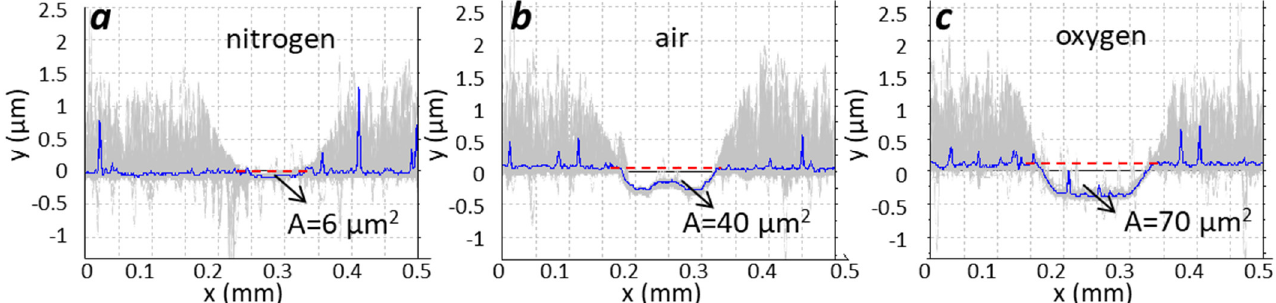
Figure 10. Series of 250 line profiles stacked together from the recorded profiles. The wear track of BAI TiN coating is shown for different surrounding atmospheres (( a )—nitrogen, ( b )—air, ( c )—oxygen). The scanning area was 0.5 mm × 0.5 mm. The blue profile represents the level of coating, while grey peaks represent protrusions. During the sliding test (1000 cycles), the protrusions were removed and the wear tracks with various depths were formed. Note the strong exaggeration in z-scale. “A” is the cross-section area of the wear track.